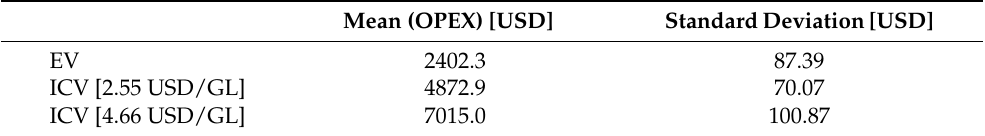
Table 4. Annual OPEX